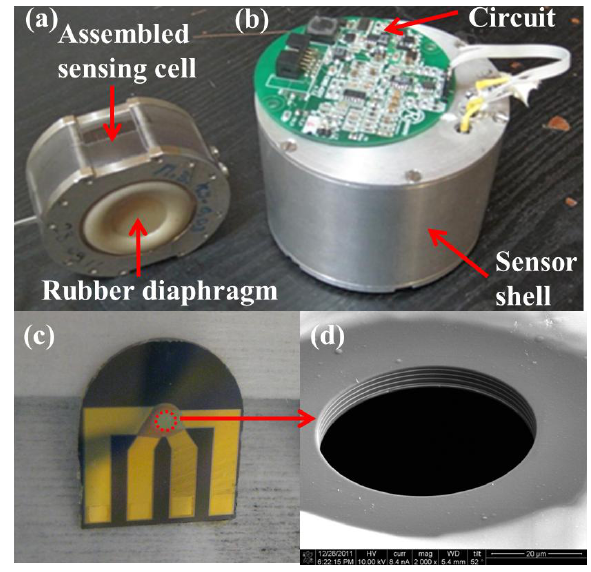
Figure 6. Fabricated MEMS MET seismometer. ( a ) assembled MET sensing cell, ( b ) sensor circuits and protection cell, ( c ) unpackaged MEMS MET core, and ( d ) Zoom-in view of the MET sensing element from scanning electron microscopy (SEM) showing stacked alternating platinum (electrodes) and silicon nitride (dielectric